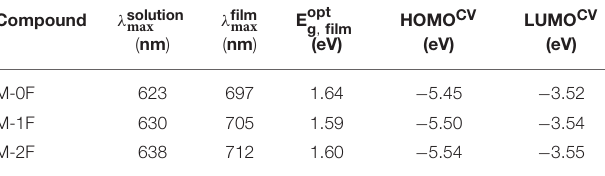
TABLE 1 | Optical and electrochemical data of compounds M1-0F, M1-1F, and